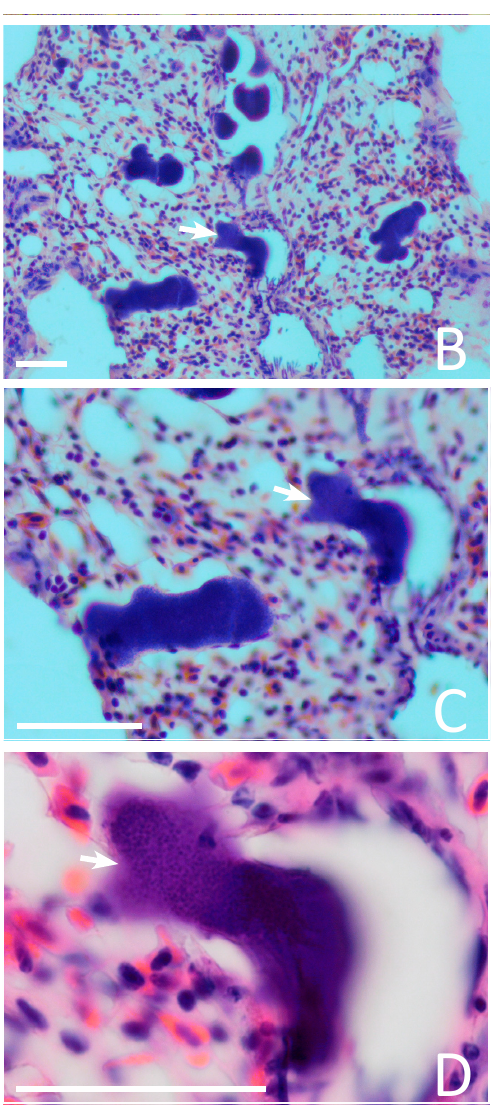
Figure 3. Gametocytes ( A – C ) and lung meronts ( D – O ) of Haemoproteus attenuatus (cytochrome b Figure 3. The same section of the lungs of European robin Erithacus rubecula, with meronts of Haem- oproteus attenuatus (cytochrome b lineage hROBIN1) shown at different magnifications, ×100 ( A ), lineage hROBIN1) in naturally infected European robin Erithacus rubecula : ( A , B ) growing macroga- ×200 ( B ), ×400 ( C ), and ×1000 ( D ). A simple white arrow shows the same meront in this group of metocyte ( A ) and microgametocyte ( B ); ( C ) fully grown macrogametocyte (top) and microgametocyte parasites. Location of meronts in groups is a characteristic feature of this infection ( A , B ). Note that (bottom); ( D , E ) groups of numerous early developing meronts; ( F – O ) variously shaped maturing meronts are markedly different in size and shapes, but the majority did not exceed 50 µm at the meronts, including those at the stage of differentiation of merozoites ( J – O ). Note that growing biggest diameter. Scale bar is 50 µm for all images. gametocytes of this parasite are markedly attenuated ( A , B ), which is particularly visible in microga- metocyte ( B ). Prominent roundish volutin granules are well-visible in gametocytes ( A , C ), particularly microgametocytes, in which they gather close to the poles of the gametocytes ( C ). The largest meronts markedly push surrounding lung tissues resulting in appearance of interrupted thick envelope-like structures, which resemble a wall around some meronts ( O ), but such structures were absent around smaller meronts, which push lung cells less ( F – I ). Simple long black arrows—gametocyte nuclei; simple black arrowheads—volutin granules; triangle black arrowheads—pigment granules; simple short white arrows—meronts at different stages of their development. Scale bars: black—10 µ m (for images A – C ), white—20 µ m (for images D – O